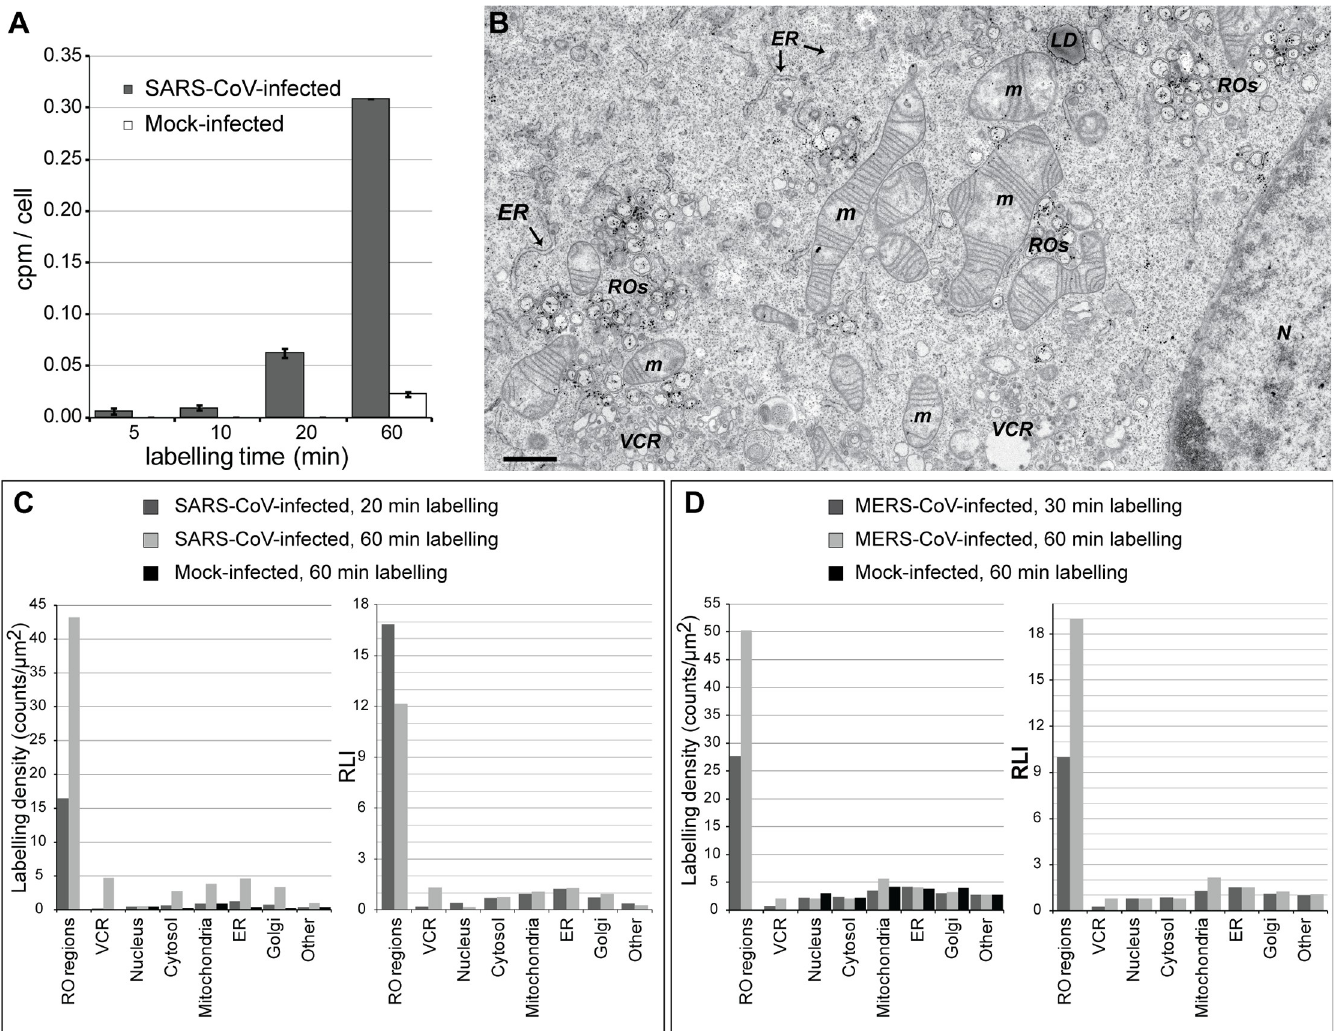
Fig 4. CoV RNA synthesis is confined to RO regions. Newly synthesized vRNA was metabolically labeled by providing tritiated uridine to CoV-infected cells pretreated with actinomycin D to limit host transcription. (A) Analysis of the amount of radioactive label incorporated into RNA as a function of the labeling time in SARS-CoV-infected Vero E6 cells (MOI 10), as measured by scintillation counting on the RNA isolated from the cells (underlying numerical data in S2 Data). The label was provided simultaneously to all the samples at 6 hpi. (B-D) EM detection by autoradiography. (B) Overview of a SARS-CoV-infected Vero E6 cell (MOI 10, 7 hpi, labeled for 20 minutes). Autoradiography grains accumulate in the RO regions. Scale bar, 1 μ m. (C, D) Quantification of the autoradiography signal per subcellular structure (see also S3 Data). Labeling densities and RLIs in different subcellular regions of (C) Vero E6 cells infected with SARS-CoV (MOI 10) or (D) Huh7 cells infected with MERS-CoV (MOI 5). Radioactively labeled uridine was provided for the indicated periods of time immediately before fixation at 7 hpi and 12 hpi, respectively. These time points represent, respectively, the middle (SARS-CoV) or late (MERS-CoV) exponential phase of viral replication [21,34]. Control mock- infected cells are excluded from the RLI plots, as RLI comparisons between conditions require the same number of classes (subcellular regions) and these cells lack ROs and virions. CM, convoluted membranes; CoV, coronavirus; cpm, counts per minute; DMS, double-membrane spherule; DMV, double-membrane vesicle; EM, electron microscopy; ER, endoplasmic reticulum; HCoV-229E, human coronavirus 229E; hpi, hours postinfection; IBV, infectious bronchitis virus; LD, lipid droplet; m, mitochondrion; MERS-CoV, Middle East respiratory syndrome-CoV; MHV, murine hepatitis virus; MOI, multiplicity of infection; N, nucleus; RLI, relative labeling index;; RO, replication organelle; SARS-CoV, severe acute respiratory syndrome-CoV; VCR, virion-containing region; vRNA, viral RNA.